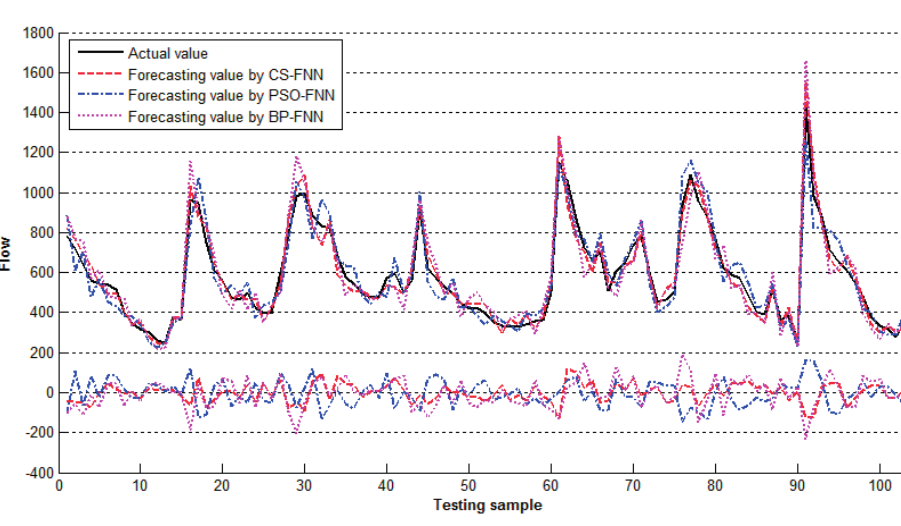
Figure 5. The forecasting and actual values in the third